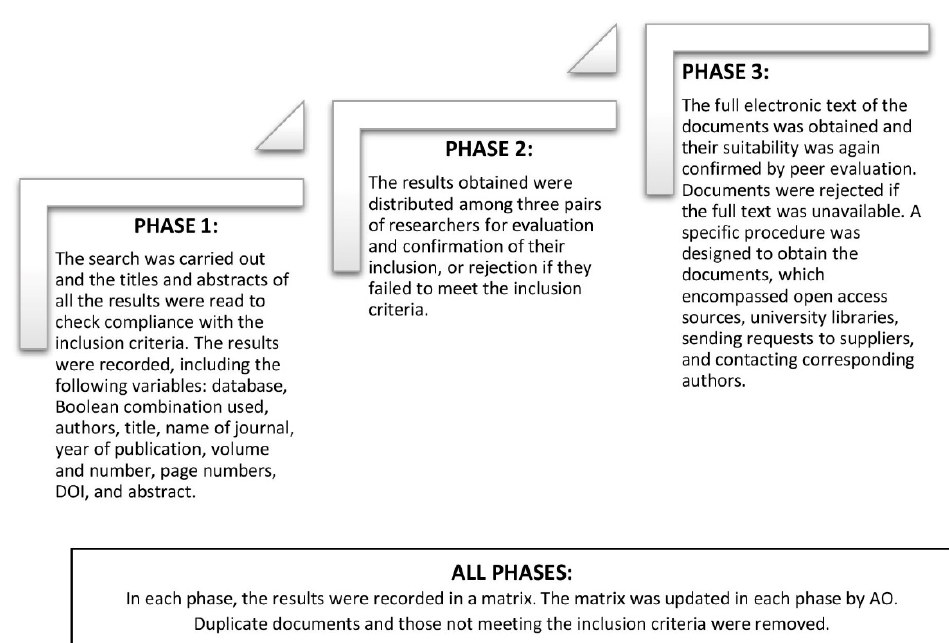
Figure 1. Screening and eligibility phases.